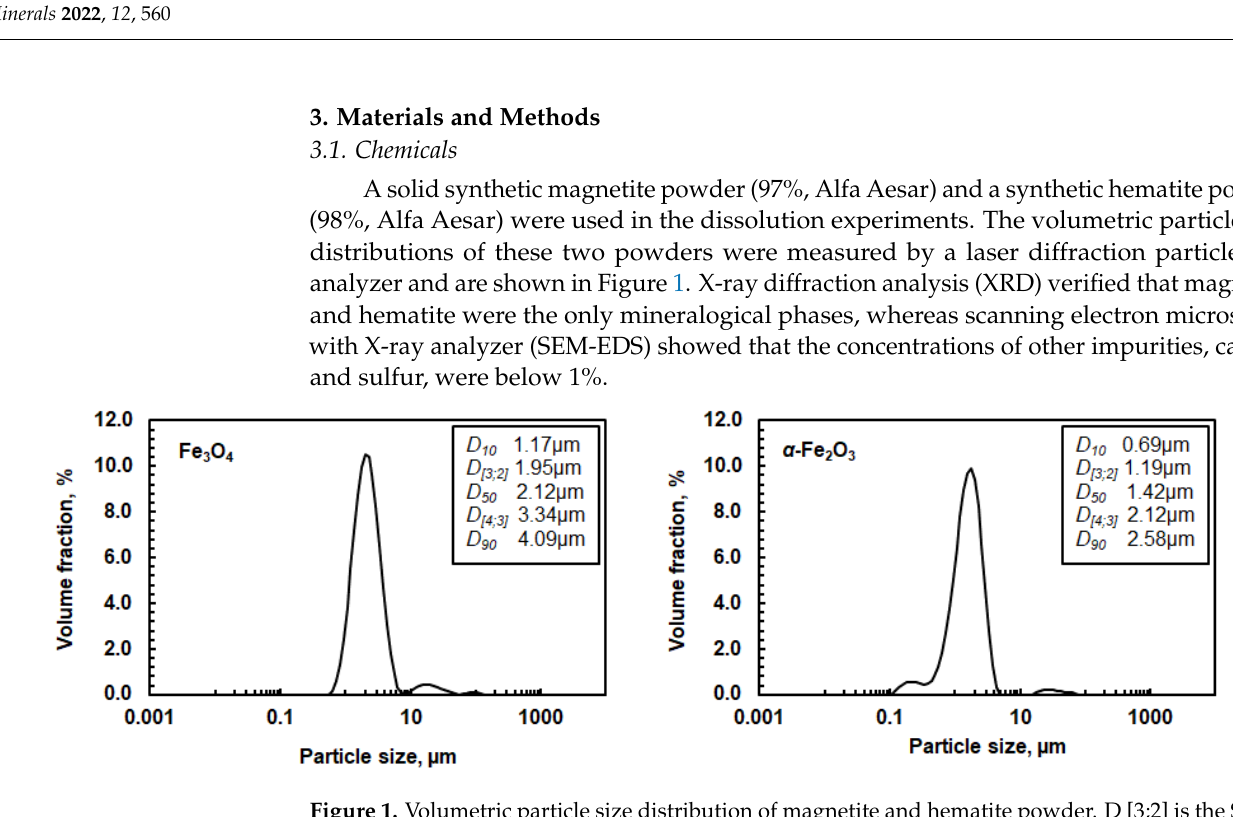
Figure 1. Volumetric particle size distribution of magnetite and hematite powder. D [3;2] is the Sauter mean diameter and D [4;3] is the volume mean diameter. D10, D50, and D90 values correspond to the size of particles that are 10, 50, or 90% smaller than all the particles in the sample,